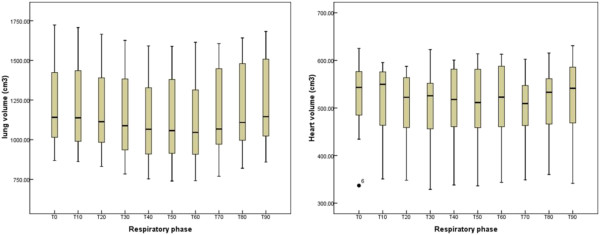
The changes in the ipslateral lung (left) and heart volume (right) in successive 4DCT phases during free breathing.